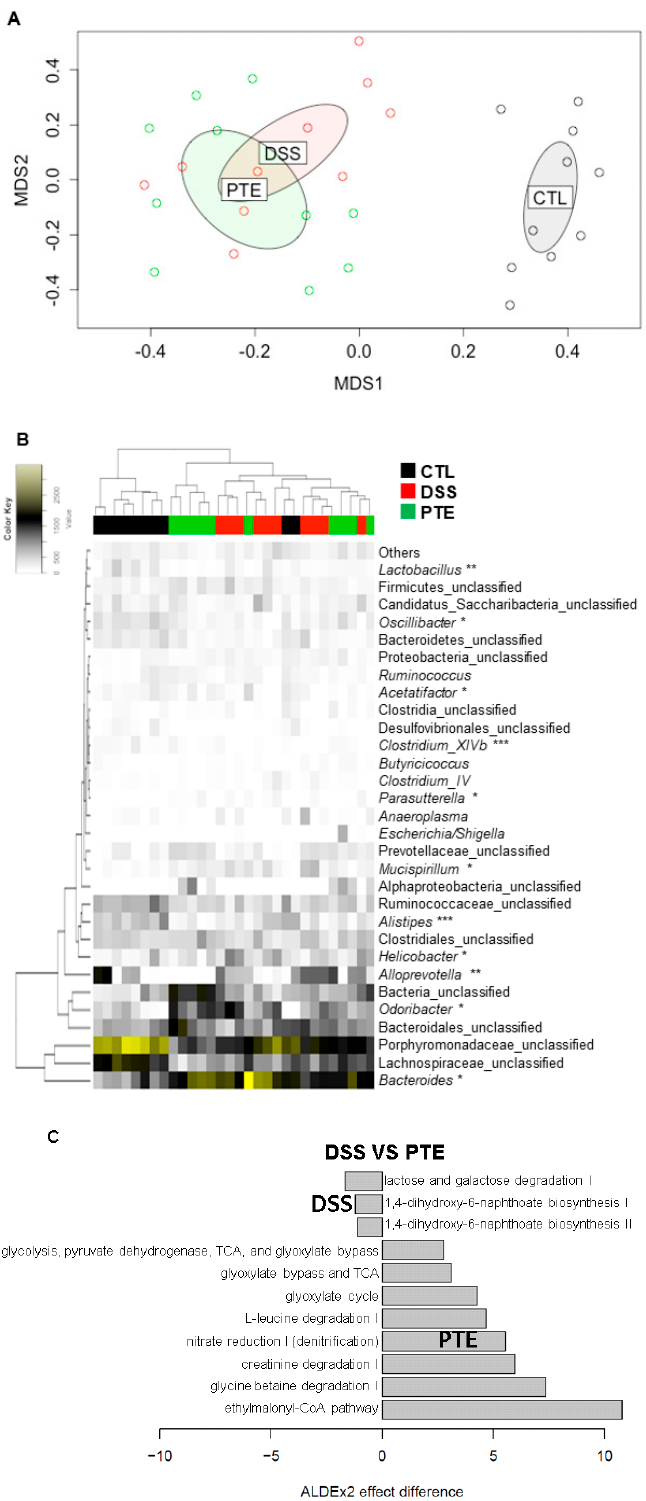
Figure 4. The comparison analysis of microbial community ( n = 10) using non-metric multidimensional scaling (NMDS) plotting and heatmap. ( A ) NMDS analysis. The ellipses were drawn with 0.95 confidence level in NMDS plotting. ( B ) Genus level taxonomic composition of relative abundance in the mice gut microbiota. *, **, and *** indicate significant di ff erence between CTL and DSS, DSS and PTE, and both, respectively. ( C ) Di ff erentially abundant predicted metabolic pathways in DSS and PTE groups. CTL, DSS, and PTE indicate normal group, DSS-treated group and DSS plus PT extracts-treated group,